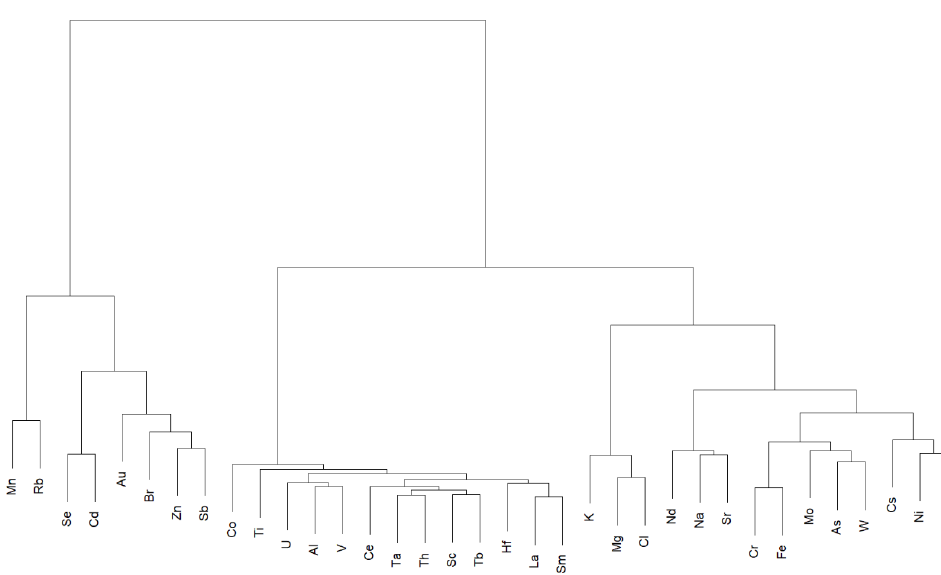
Figure 5. Correlation-matrix-based hierarchical clustering result. Map outputs were created on the basis of the INAA results. Cr, Fe, Mo, As, W, Ni and Ba were chosen for a detailed study of spatial distribution (Figures 6–9). The distri- bution of these elements in the Tritia region is similar. All the selected elements show increased values in the Katowice area. All the selected chemical elements, except for As, show increased concentrations in the vicinity of Cz˛estochowa. Increased concentrations of Mo, W and Fe are observed in the Ostrava-Karviná agglomeration. In the area between the towns of Bohumín and Rybnik, there is a locality where all the selected chemical elements, with the exception of As, are elevated.